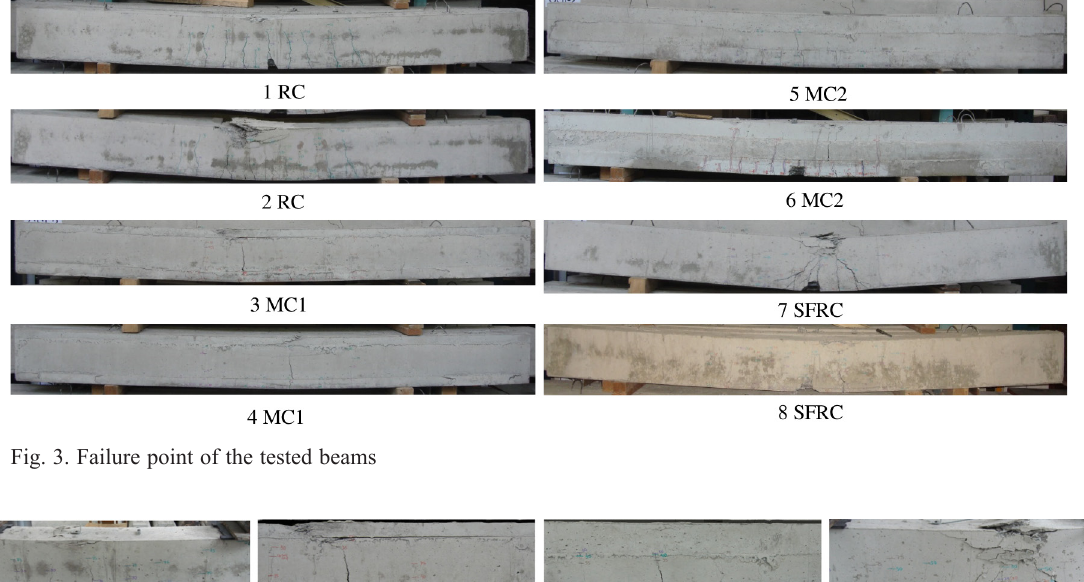
Fig. 3. Failure point of the tested beams